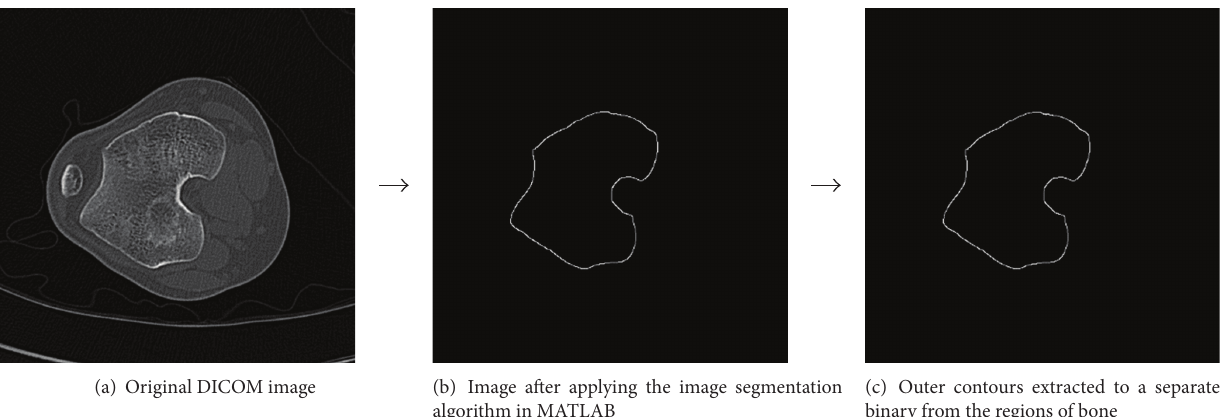
Figure 3: Segmentation procedure for the knee joint by the Canny edge detection algorithm (where input parameters 𝜎 = 2 , low threshold = 0.10, and high threshold = 0.